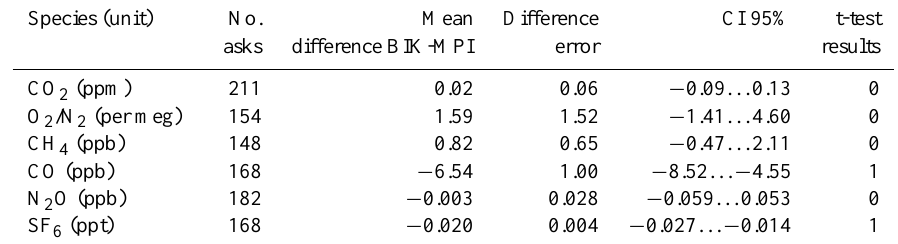
Table 3. Results of the comparison between in-situ and flask sample results. Differences are in-situ minus flasks. Species (unit) No. Mean Difference CI 95% t-test flasks difference BIK-MPI error results CO 2 (ppm) 211 0.02 0.06 − 0.09...0.13 0 O 2 /N 2 (per meg) 154 1.59 1.52 − 1.41...4.60 0 CH 4 (ppb) 148 0.82 0.65 − 0.47...2.11 0 CO (ppb) 168 − 6.54 1.00 − 8.52... − 4.55 1 N 2 O (ppb) 182 − 0.003 0.028 − 0.059...0.053 0 SF 6 (ppt) 168 − 0.020 0.004 − 0.027... − 0.014